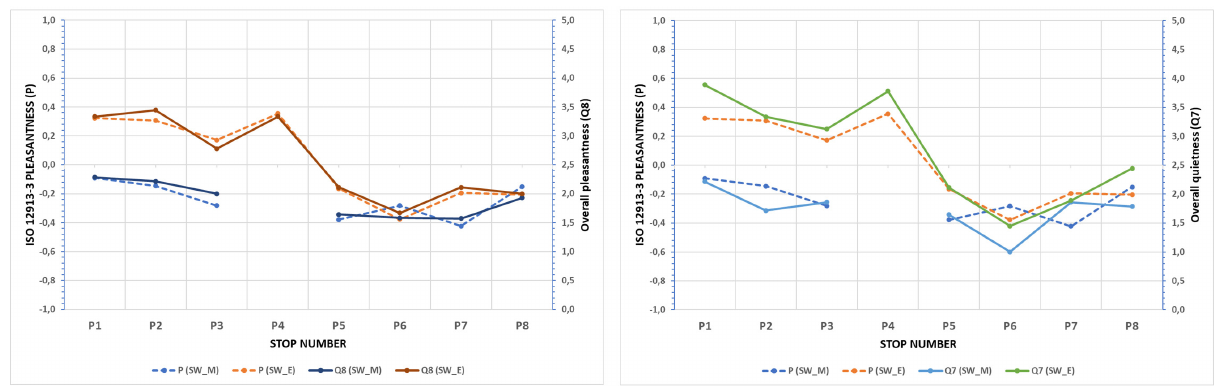
Figure 21: Pleasantness “P” estimated according to ISO 12913-3 2019 and overall mean pleasantness (Q8, left) and quietness (Q7, right) at every stop during morning and evening